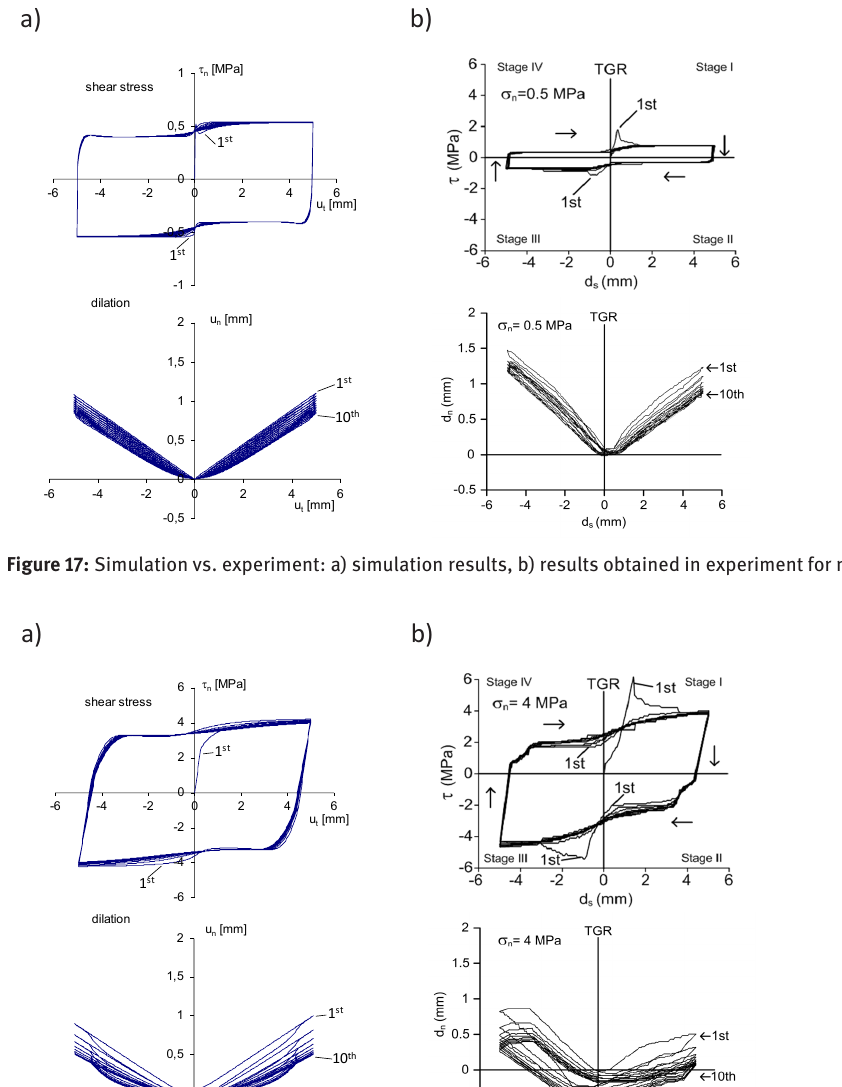
Figure 18: Simulation versus experiment: a) simulation results, b) results obtained in experiment for normal load σ